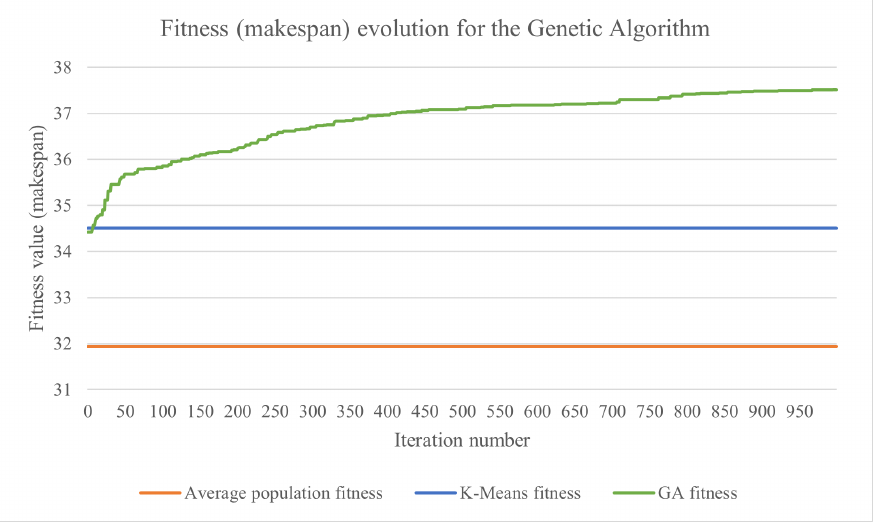
Figure 9. The evolution of the best chromosome’s fitness for a genetic algorithm that uses the makespan as the fitness function, with the average population fitness and k-means fitness for reference.